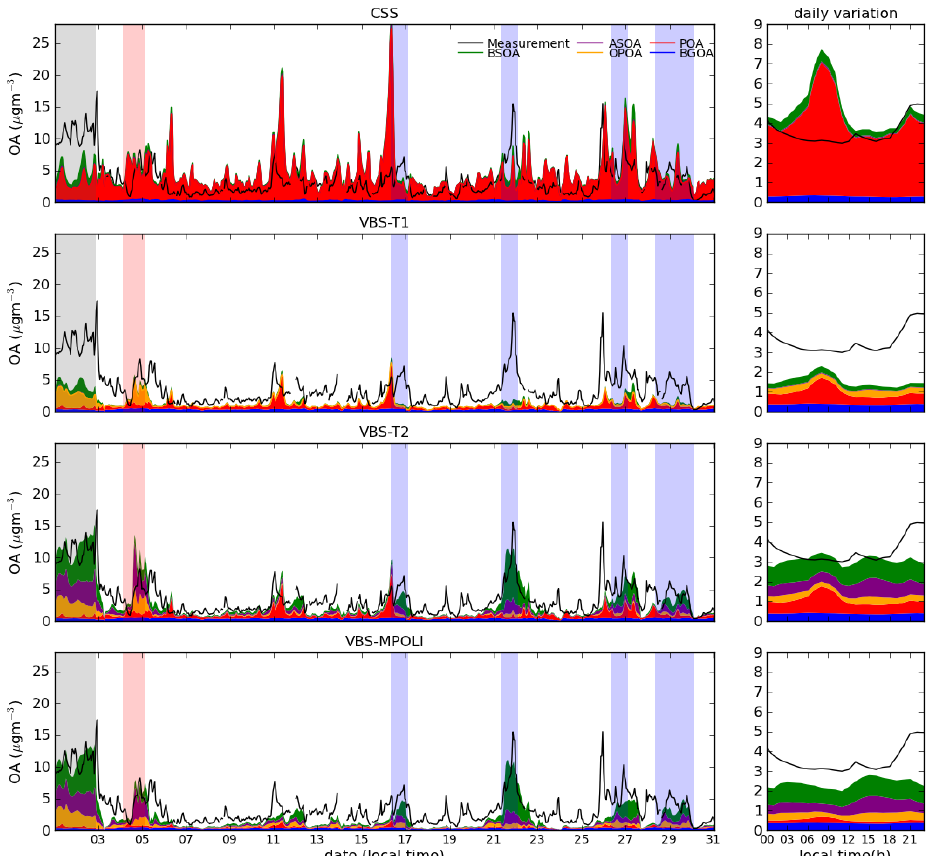
Fig. 7. Comparison of simulated and observed organic aerosol at GOLF. On the left side, time series; on the right side, daily averages for Fig. 7 Comparison of simulated and observed organic aerosol at GOLF. July On the left hand, time series; on the right side, daily averages for July 2009.